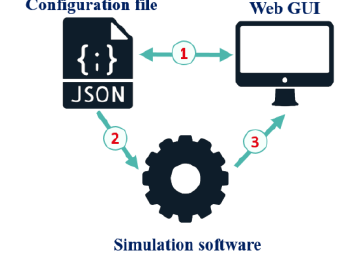
Fig.2. The simulation tool